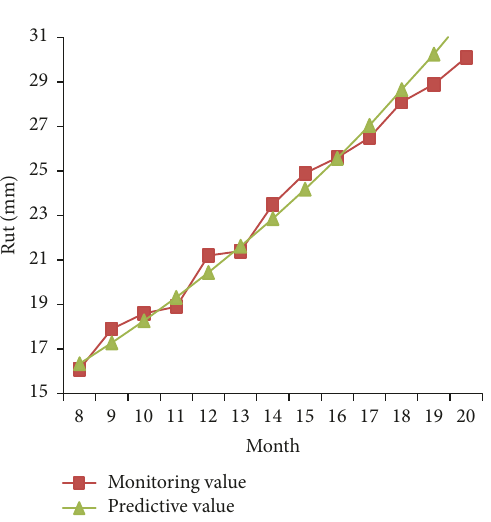
Figure 5: The change curves of